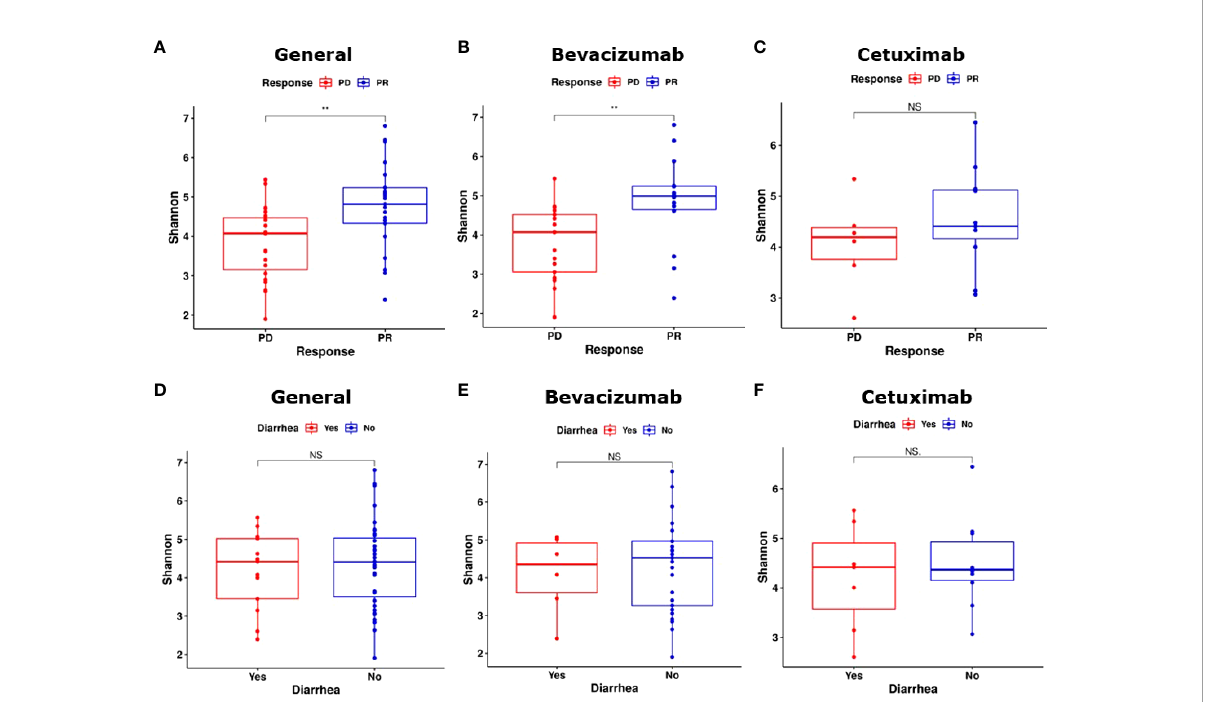
FIGURE 2 Results on a -diversity of groups and subgroups. (A) The PR group had a signi fi cantly higher a -diversity than did the PD group ( P < 0.01). (B) a - diversity signi fi cantly differed between the bevacizumab-PD and PR subgroups ( P < 0.01). (C) Bacterial species richness did not signi fi cantly differ between the cetuximab-PR and cetuximab-PD subgroups ( P = 0.35). (D) a -diversity did not signi fi cantly differ between the “ substantial diarrhea ” and “ minor or no diarrhea ” groups ( P = 0.57). (E, F) a -diversity did not signi fi cantly differ between the bevacizumab and cetuximab diarrhea subgroups (bevacizumab-PR vs. bevacizumab-PD and cetuximab-PR vs. cetuximab-PD, P =0.72 and P =1.00, respectively). NS, Not signi fi cant; **: P <